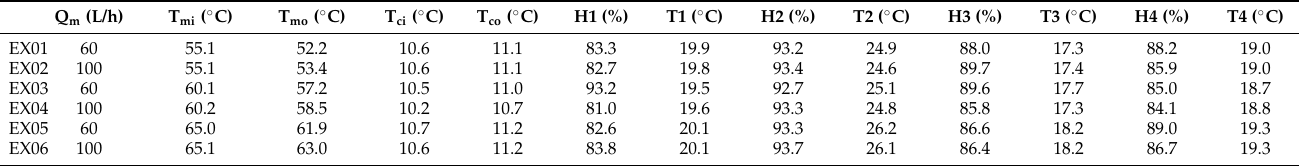
Table 2. Measured temperatures and humidity for